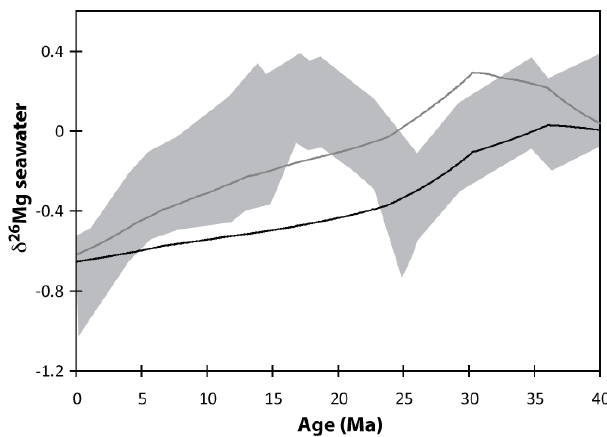
Figure 5. Model showing the effect on the fixed sink model when the river flux and isotope ratios are held constant at modern val- ues (black line), and when only the riverine isotope ratios are held constant (grey line – river flux derived from Lear et al., 2003; see text for details). The grey field represents the seawater record de- rived from